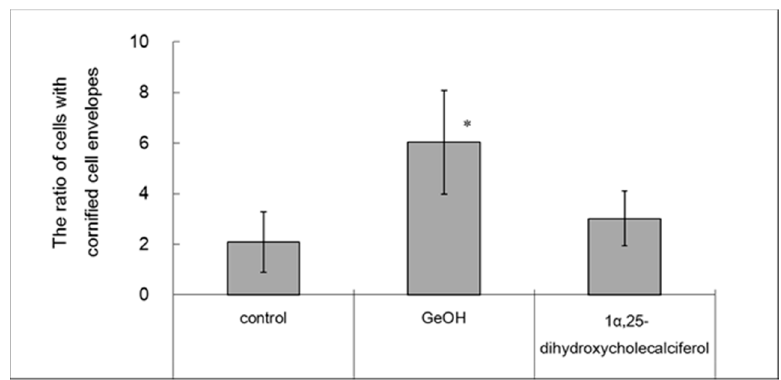
Figure 4. Effect of GeOH on TGase1 expression level in a three-dimensional human epidermis model. ( a ) mRNA expression level: Epidermis models were cultured for 3 days in medium supplemented with 100 µ g/mL GeOH. Total RNA was isolated from the cells, and quantitative reverse transcription-polymerase chain reaction was performed using four samples. The results are shown relative to the control. * p < 0.05 vs. control at the ∆ Ct stage; ( b ) Immunohistochemical staining: After 3 days of culture of the epidermis models with or without GeOH, cryosections were stained with anti-TGase1 monoclonal antibody and Alexa Fluor 488 goat anti-mouse IgG. The results are presented as the representative result of three experiments.